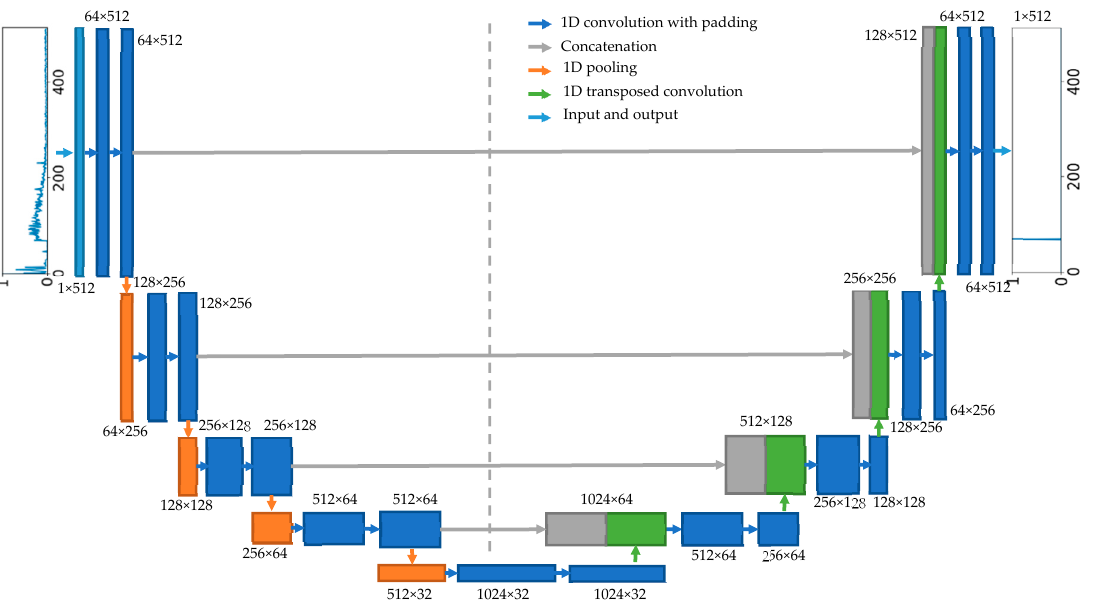
Figure 4. Structure of the proposed 1D-UNet for bottom detection from backscatter strength data of the conventional side-scan sonar.